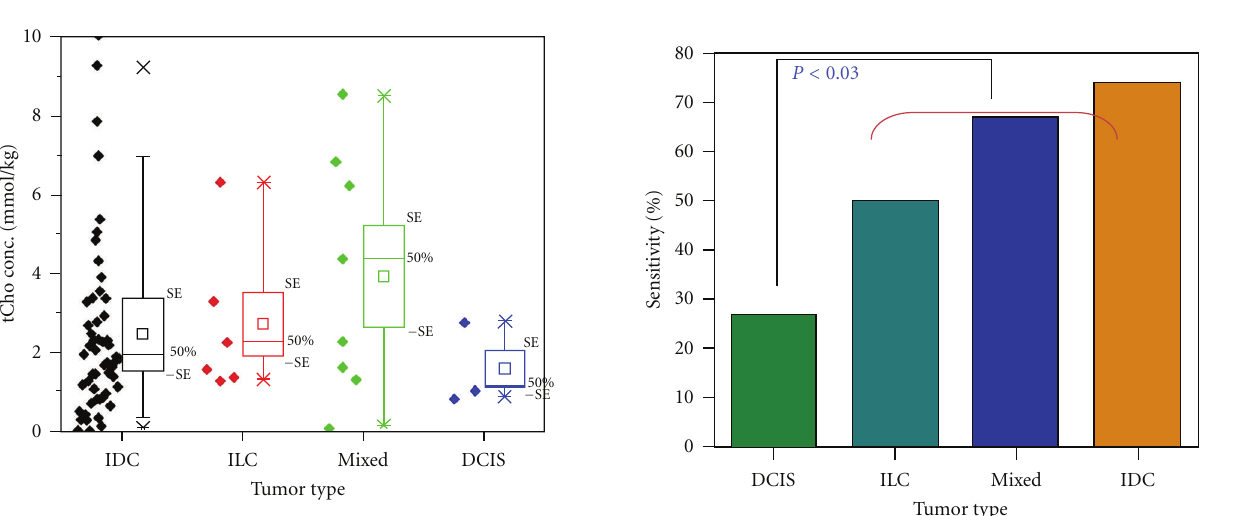
Figure 5: Sensitivity of breast 1 H-MRS in di ff erent tumor size groups. The sensitivity increased from 46% (Group A, 1.0–1.9 cm), to 70% (Group B, 2.0–2.9 cm), and 82% (Group C, 3.0cm and above), in a statistically significant manner ( P < 0 . 0001, two-sided exact Kruskal-Wallis test).